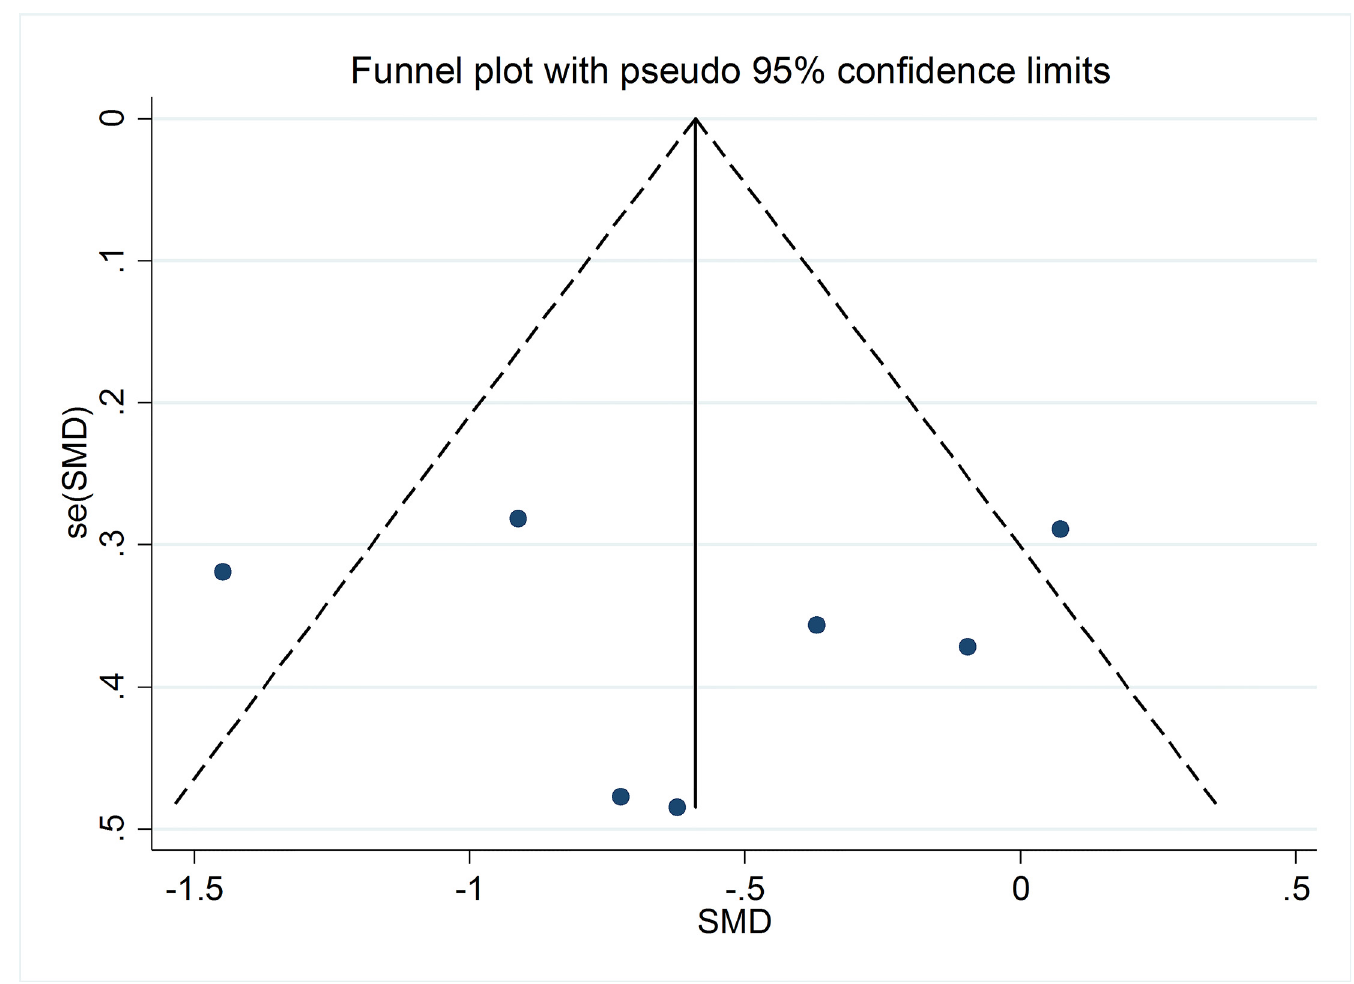
Fig 8. Funnel plot with pseudo 95% confidence limits for studies with LTB